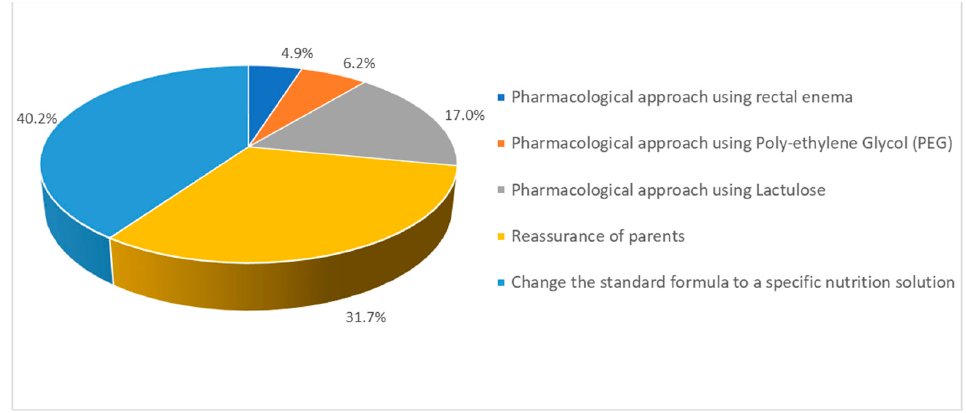
Figure 4. The reported first choice of management of FC. (% of total number of